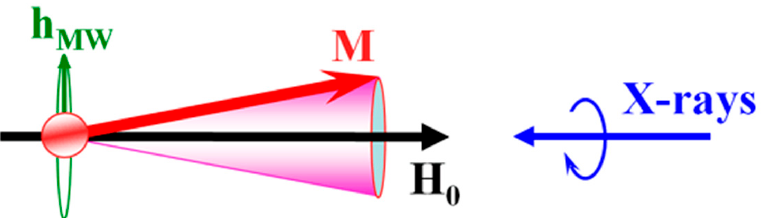
Figure 5. Setup of the XDMR experiments (h MW —magnetic field of the microwave radiation, H 0 —bias static magnetic field, M—processing magnetic vector) .